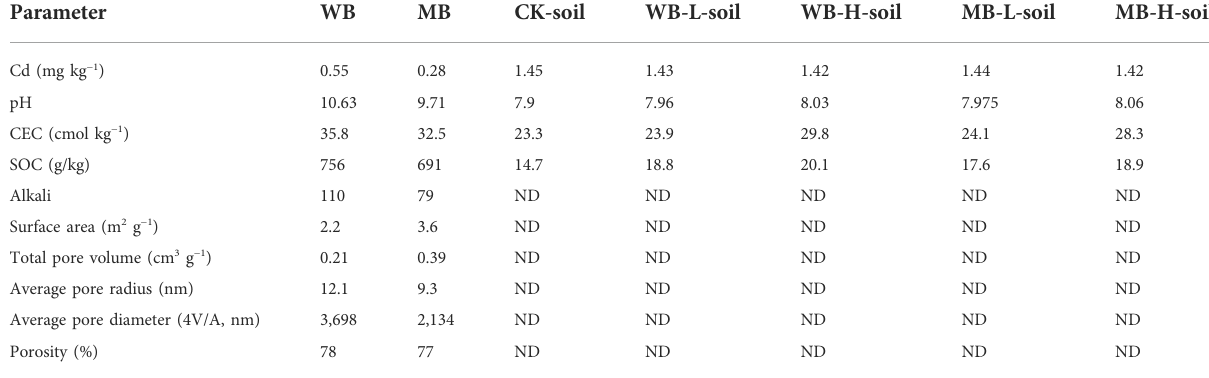
TABLE 1 Basic properties of soil and